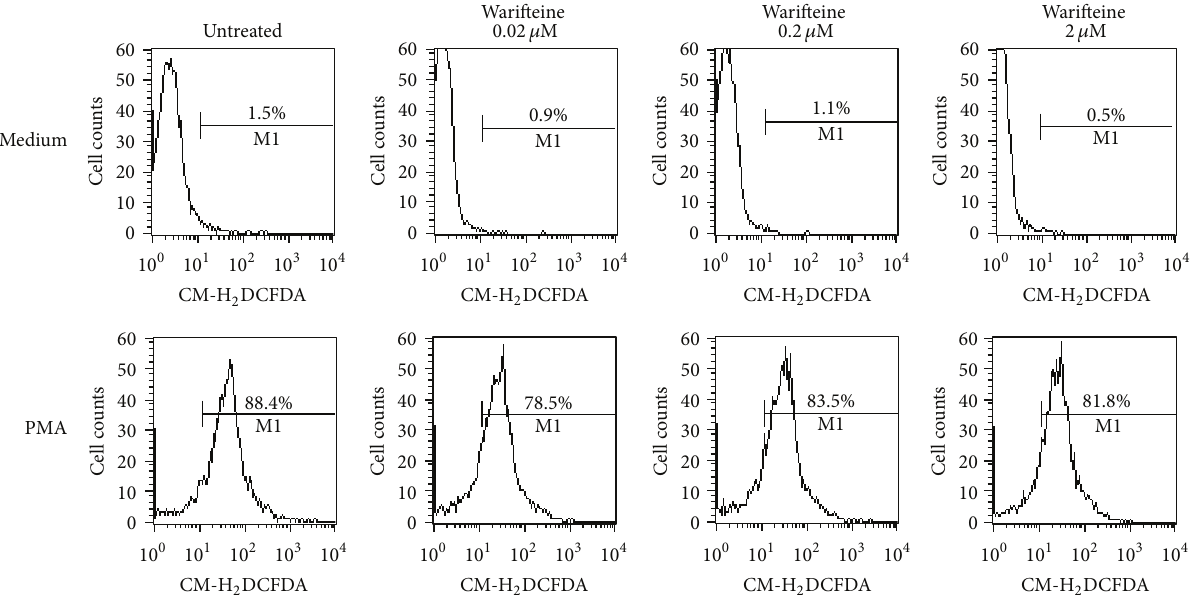
Figure 4: Measurement of reactive oxygen species in cultures stimulated with PMA and treated with warifteine. Neutrophils were incubated in either the presence or absence of PMA. Some cultures were also treated with the indicated doses of warifteine. The samples were then incubated with the probe CM-H 2 DCFDA. The production of ROS was analyzed by flow cytometry. The M1 marker shows the percentage of cells that metabolized the probe. The data are representative of three independent